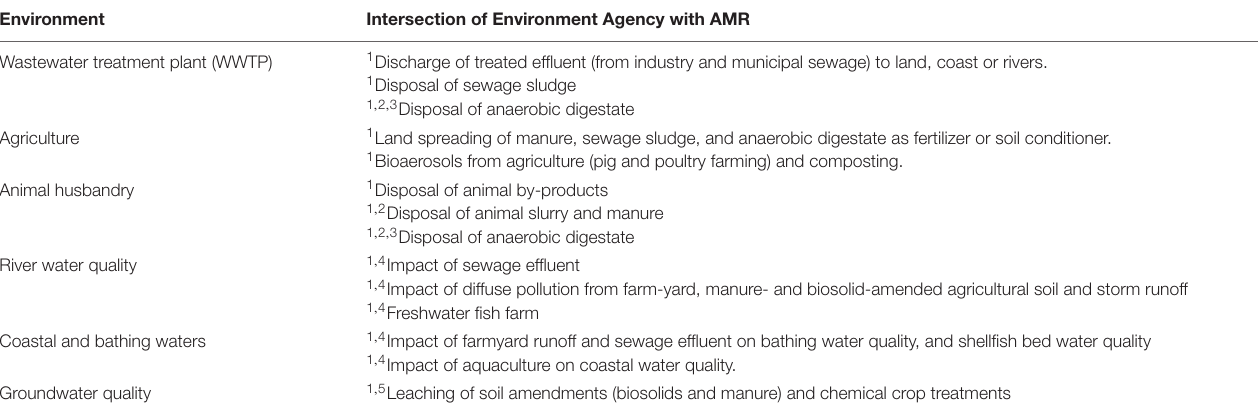
TABLE 1 | Environment and activities or products monitored or regulated by the Environment Agency of England, which play a potentially important role in the spread and maintenance of AMR in the environment.